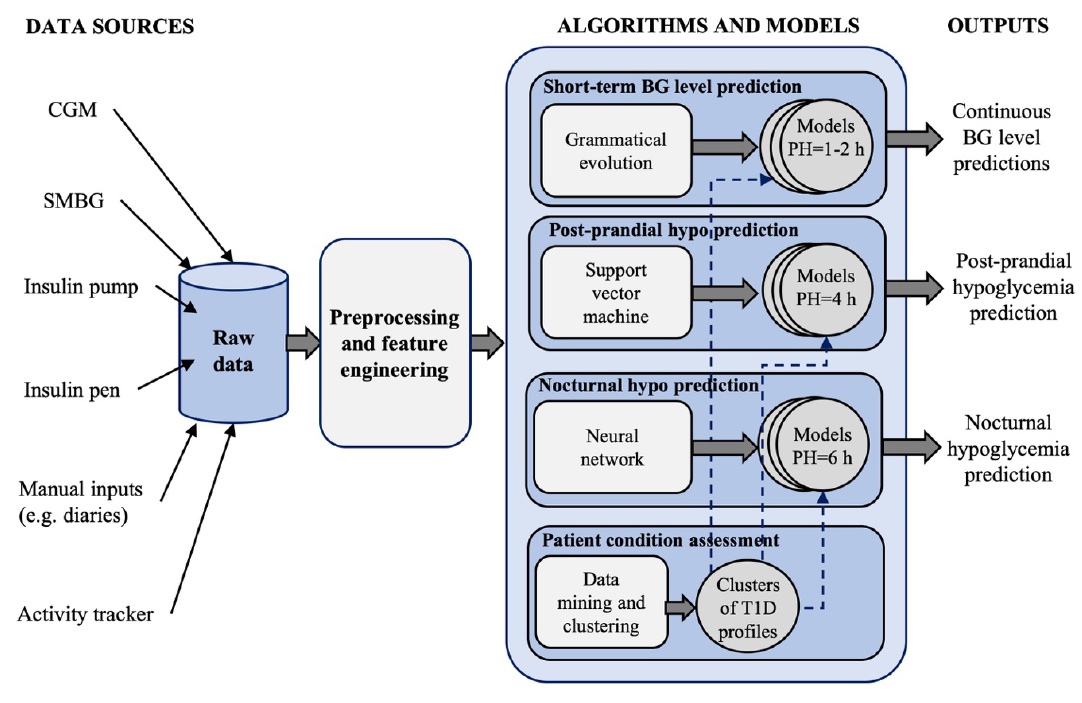
Figure 5. Schematic representation of a proposed Patient Safety System (adapted from Figure 2 of [61]).